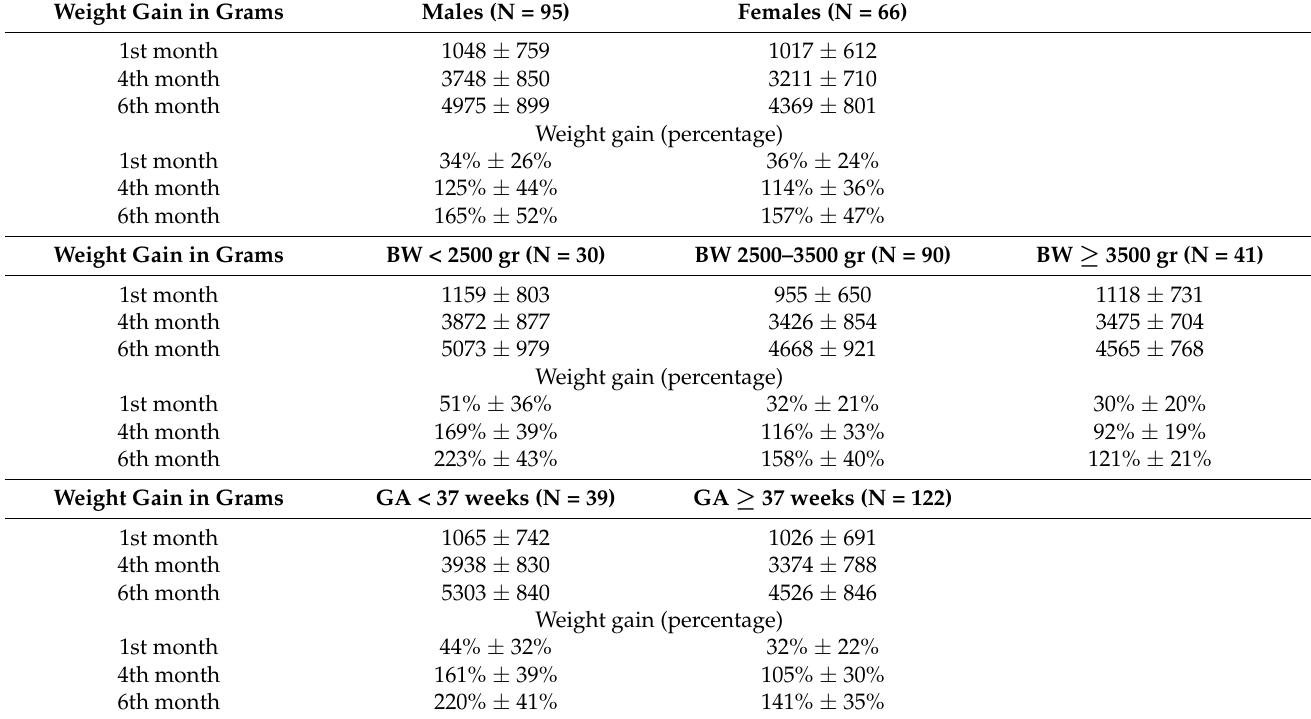
Table 5. Weight gain at 1st, 4th, 6th month of age in relation to gender, birth weight (BW) group and gestational age (GA)